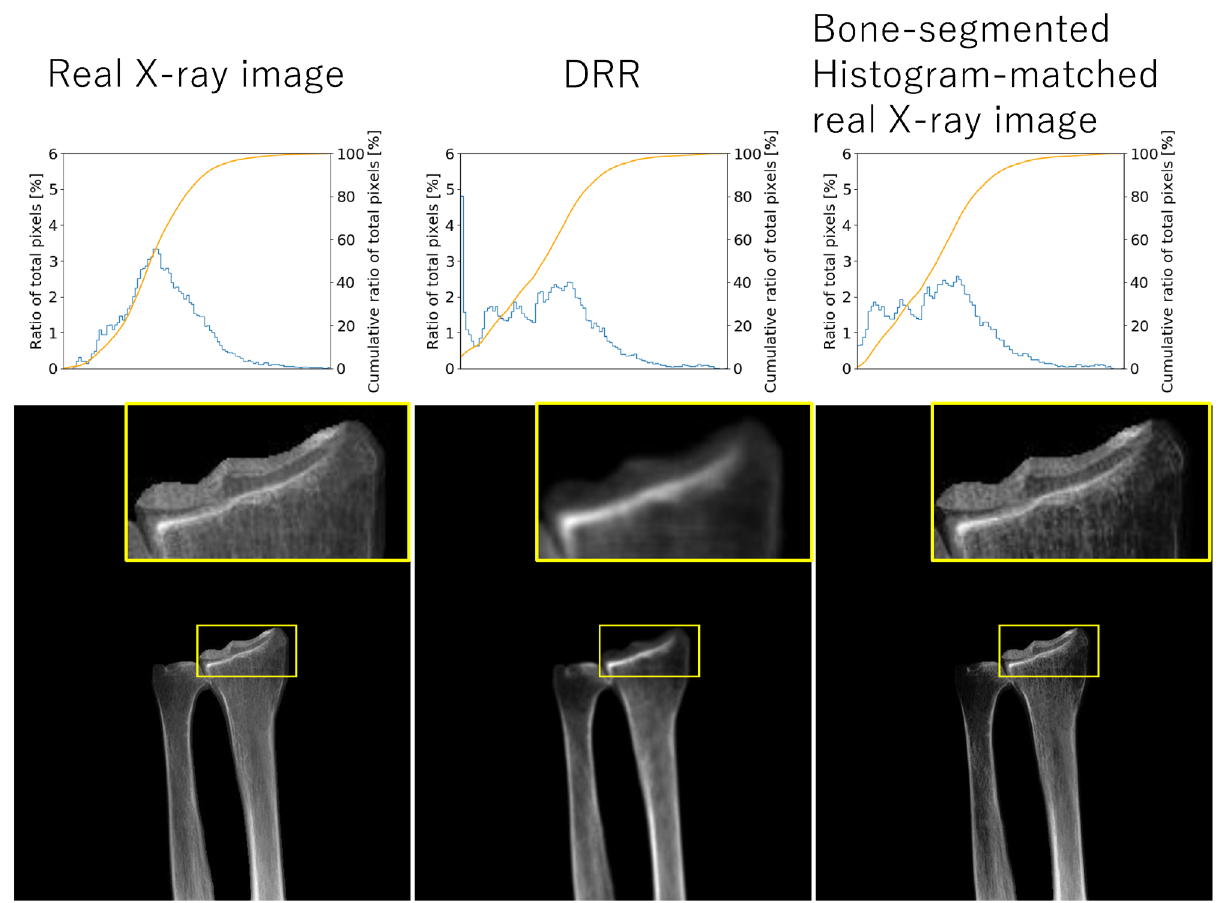
Figure 4. Visualization result of mean absolute error (MAE): ( a ) example of small error, MAE: 0.016 ± 0.020; ( b ) example of large error, MAE: 0.051 ±